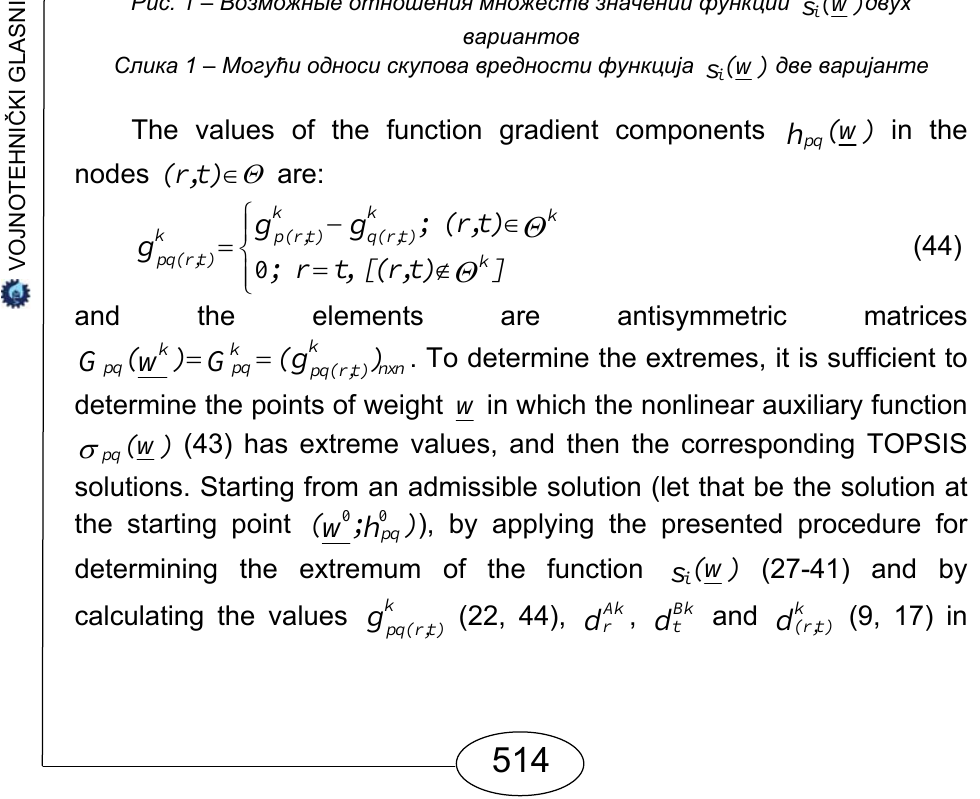
Figure 1 – Possible relations of the set of function values )w( s Рис . 1 – Возможные отношения множеств значений функций )w( s